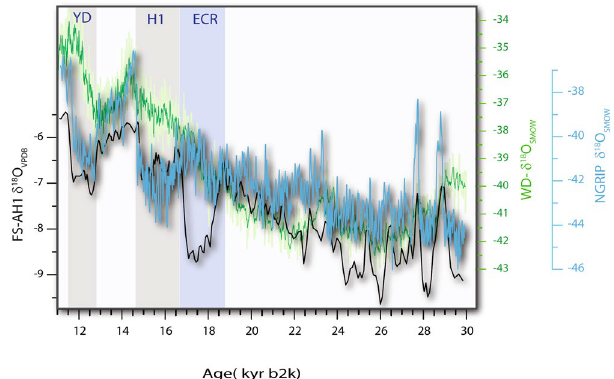
Figure 3. Detailed comparison of the Northern Hemisphere Greenland ice-core NGRIP δ 18 O time-series 5 and the Southern Hemisphere polar ice core West Antarctic Ice Sheet (WAIS) Divide ice core δ 18 O data (WDC) 22 against the FS-AH1 record. The secular trends in the three records are remarkably similar through the LGM, showing that the growth of Northern Hemisphere ice sheets and deglaciation took place in the background of concurrent bi-polar warming with only a slight change during the ECR in both poles. The two poles diverge during the Northern Hemisphere cooling associated with HS1 proper and the three records rapidly changing during the transition to the Bølling-Allerød. The largest shift in the AH1 occurs during ECR, which is also the case for many tropical and subtropical hydroclimate and SST proxies (Fig.